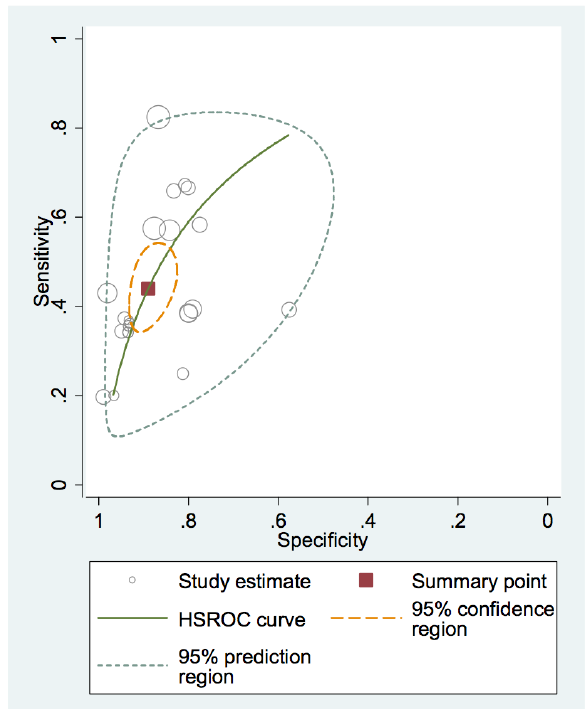
Figure 8: The pooled HSROC for serum CA72-4 in the diagnosis of colorectal cancer